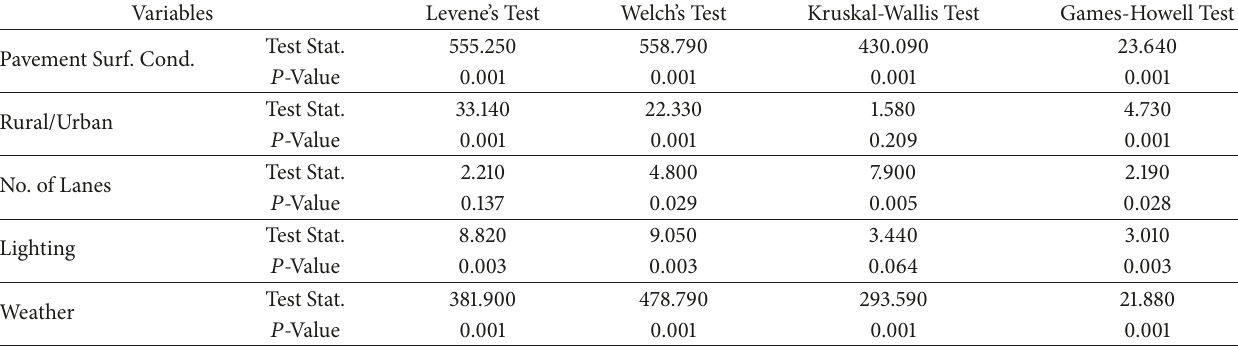
Table 9: Test for equality of mean, homogeneity of variances, and similarity in distribution of the aggregate crashes across the categorical variables.